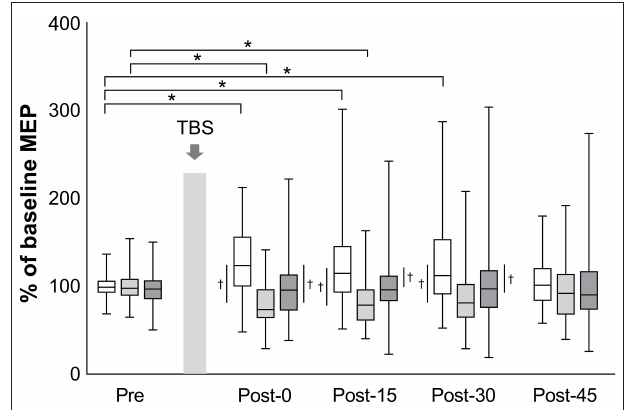
FIGURE 2 | Effects of TBS on corticospinal excitability. The amplitudes of MEP are normalized to the baseline MEP values. White box plots indicate iTBS; light gray, cTBS; dark gray, sham iTBS. Median and interquartile ranges are represented by horizontal lines within boxes and whiskers (representing minimum and maximum values), respectively. The asterisk denotes significant differences between Pre and each time point within the conditions. The dagger denotes significant differences between each condition at each time point ( P <